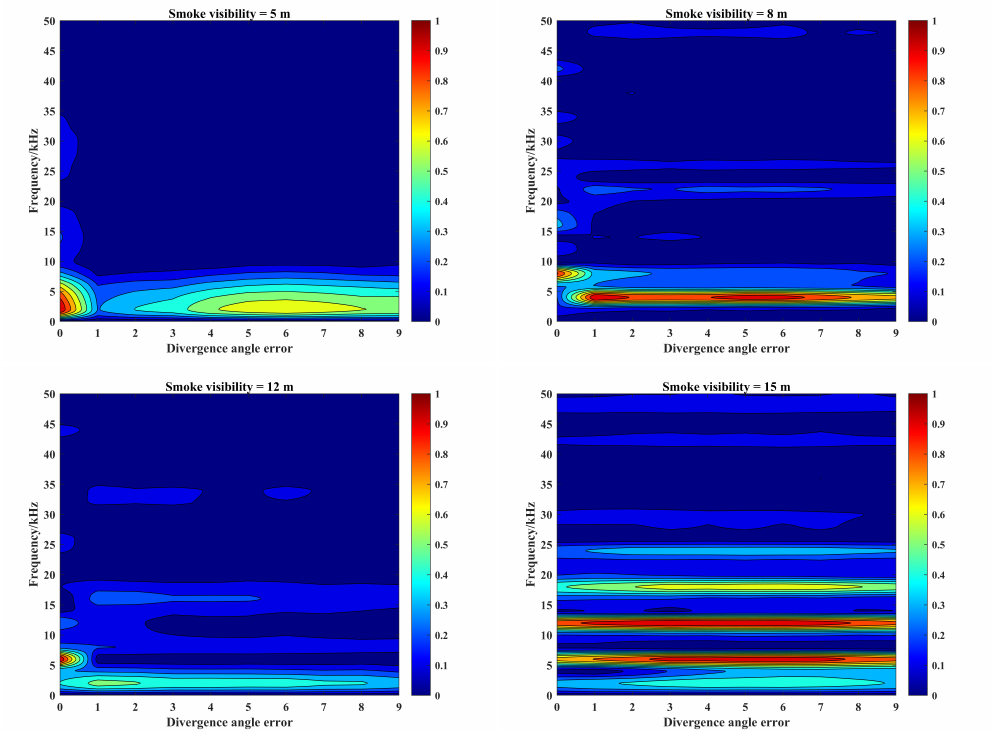
Figure 12. Amplitude–frequency characteristics of beat signals corresponding to the field of view errors of photoelectric detector under different smoke visibility